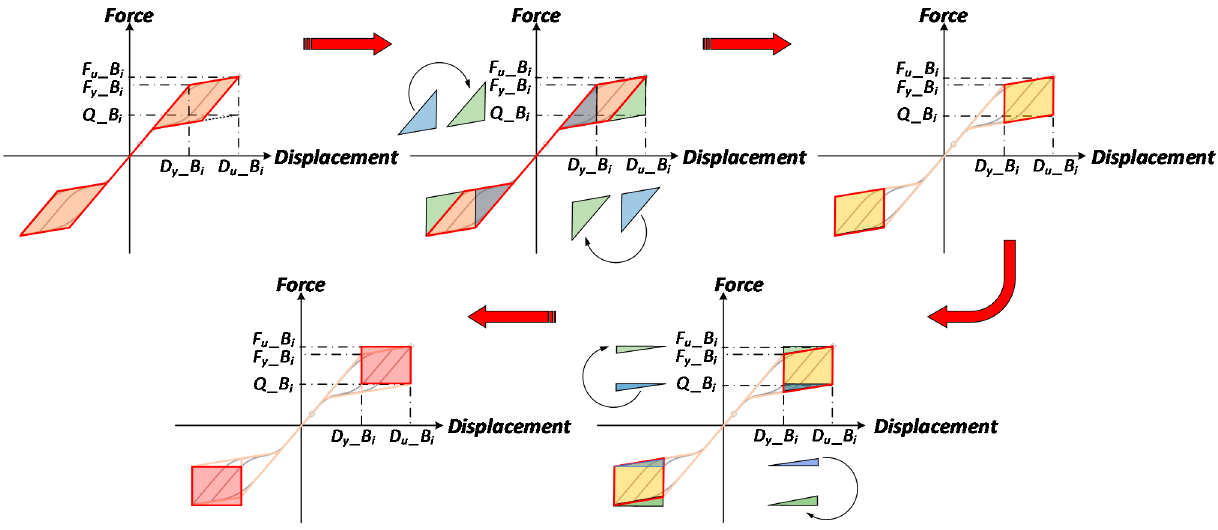
Figure 14. Adopted bilinear curve for obtaining seismic parameters.